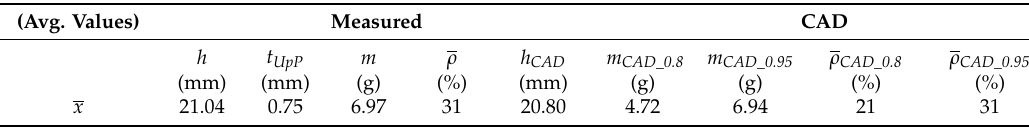
Table 2. The initial analysis of the C-series.